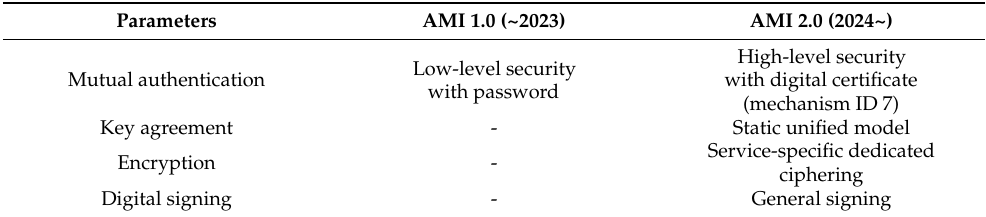
Table 2. DLMS security (SMGW ←→ smart meter)